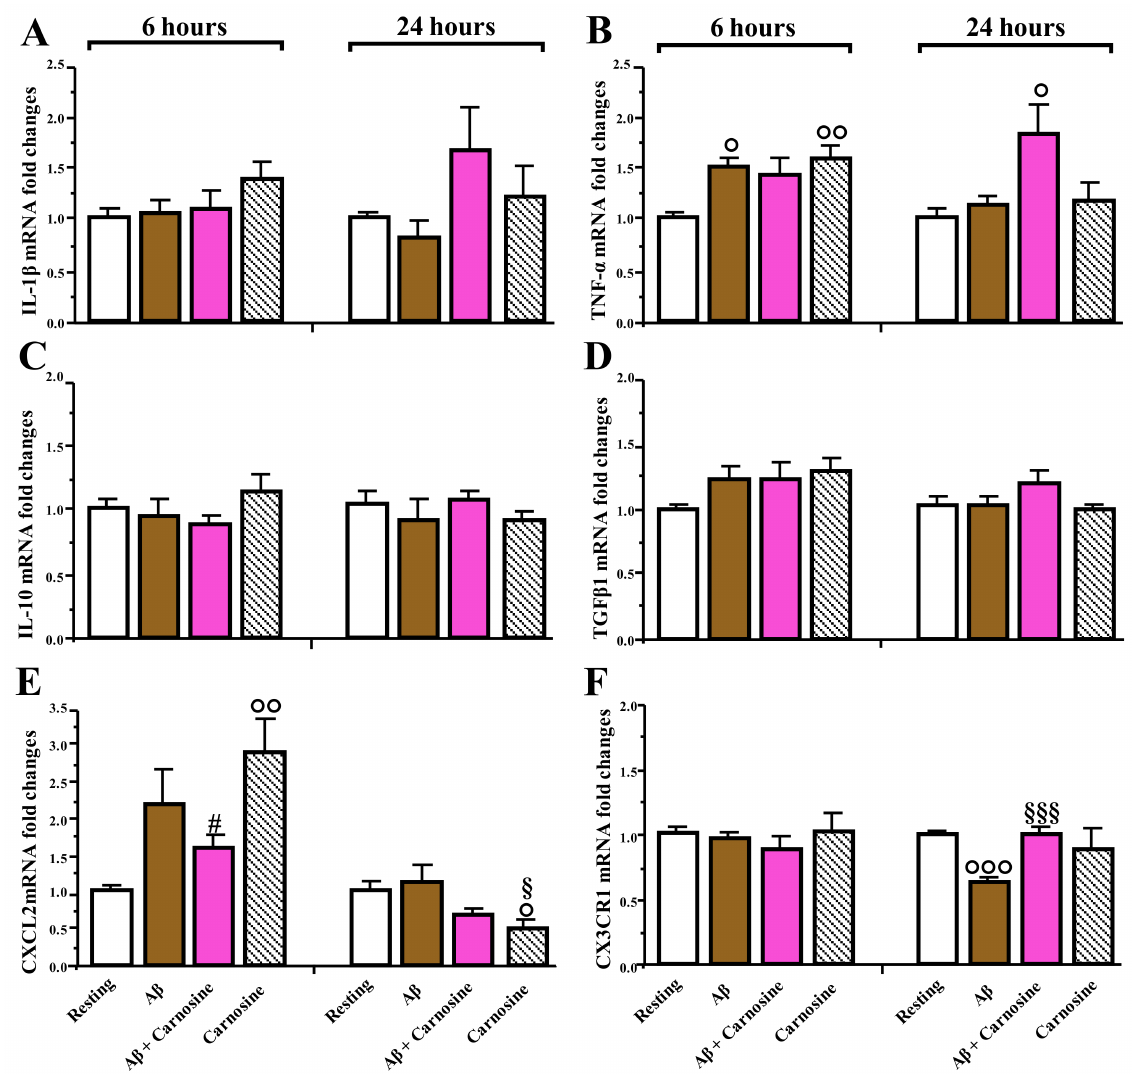
Figure 6. Effects of exposure of RAW 264.7 cells to A β 1-42 oligomers (2 µ M) for 6 and 24 h in the absence or presence of carnosine (20 mM; 1 h pre-treatment) on expression levels of immune-related targets. mRNA expression of ( A ) interleukin (IL)-1 β , ( B ) tumor necrosis factor (TNF)- α , ( C ) IL-10 , ( D ) transforming growth factor (TGF)- β 1 , ( E ) macrophage inflammatory protein-2 (CXCL2) , and ( F ) CX3CR1 , with GAPDH / CypA as endogenous controls, was measured by qRT-PCR. Data are represented as means ( n = 8–12) ± S.E.M. ◦ significantly different from resting cells, p < 0.05; ◦◦ significantly different from resting cells, p < 0.01; ◦◦◦ significantly different from resting cells, p < 0.001; § significantly different from A β 1-42 oligomer-treated cells, p < 0.05; §§§ significantly different from A β 1-42 oligomer-treated cells, p < 0.001; # significantly different from carnosine alone, p <